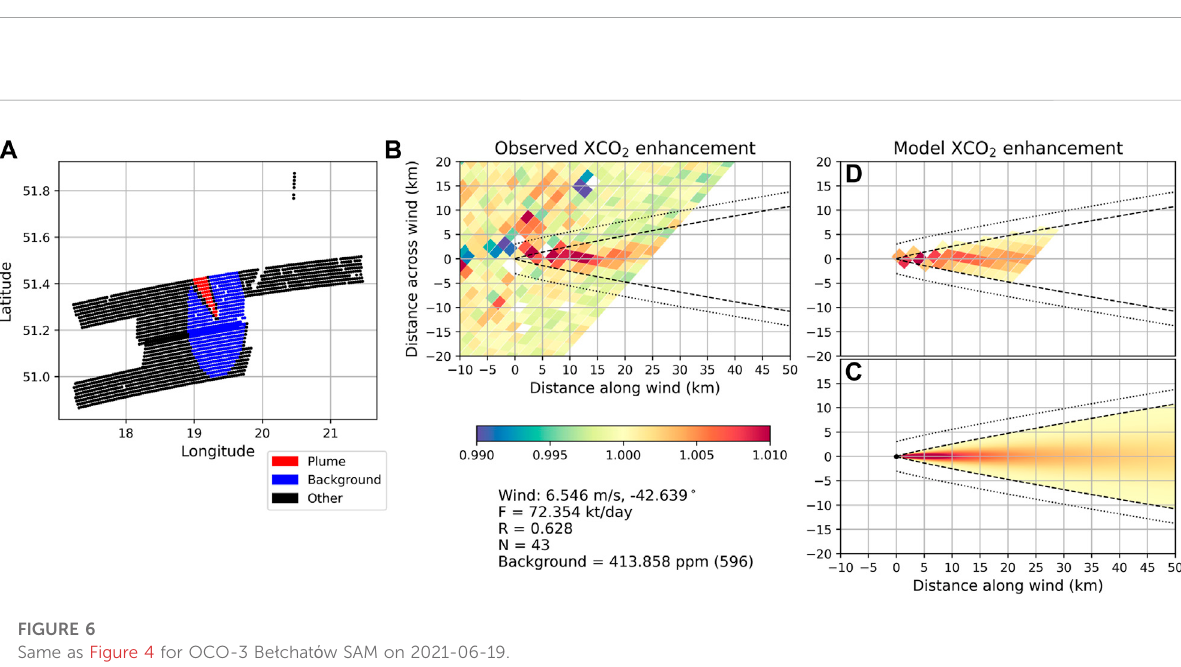
FIGURE 5 Same as Figure 4 for OCO-3 Be ł chat ό w SAM on 2020-04-17. Panel (D) indicates that the plume is fi t beginning at 8 km from the source due to issues near the plume origin possibly related to geolocation